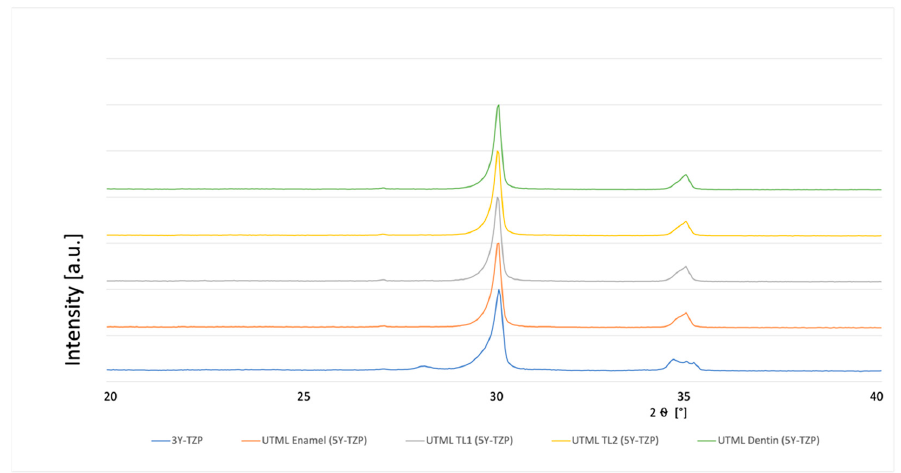
Figure 5. XRD analysis 3Y-TZP and 5Y-PSZ 600 Grit and fully sintered before cutting.